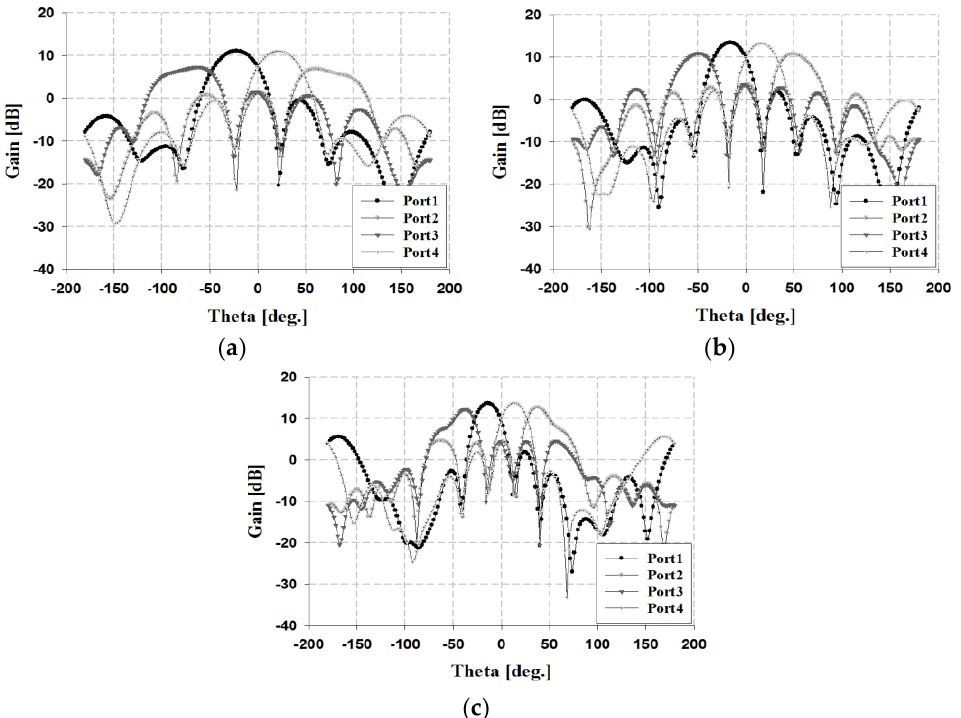
Figure 24. Simulation results of the fabricated phased array antenna at each frequency: ( a ) 3, ( b ) 4, and ( c ) 5 GHz.